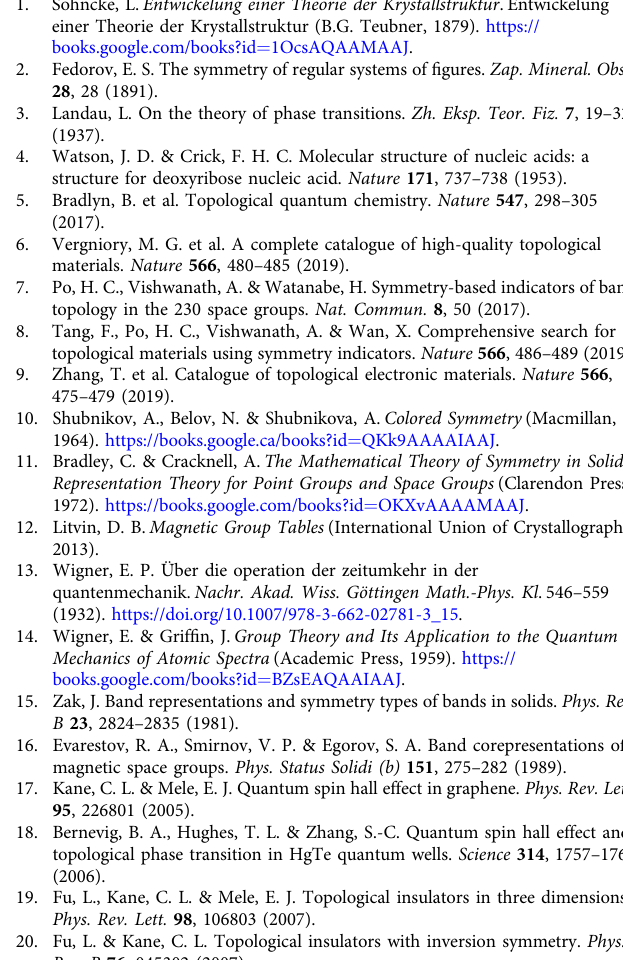
Fig. 5(c-e) were sanded to expose mirror-symmetric 2D surfaces, each surface would exhibit two anomalous, mirror-protected, twofold Dirac cones, analogous to the mirror-protected helical hinge states of SnTe discussed in ref. 28 . Lastly, we emphasize that the magnetic HOTIs in Fig. 5(c,e) exhibit the same nontrivial double SI z 4 = 2 as T -symmetric helical HOTI phases in (cid:1) supergroups of Type-II double SG 2.5 P 11 0 (see Table 2 and refs. 6,8,9,33,34 ). Unlike for AXIs and 3D TIs 19 – 21,63 , the bulk